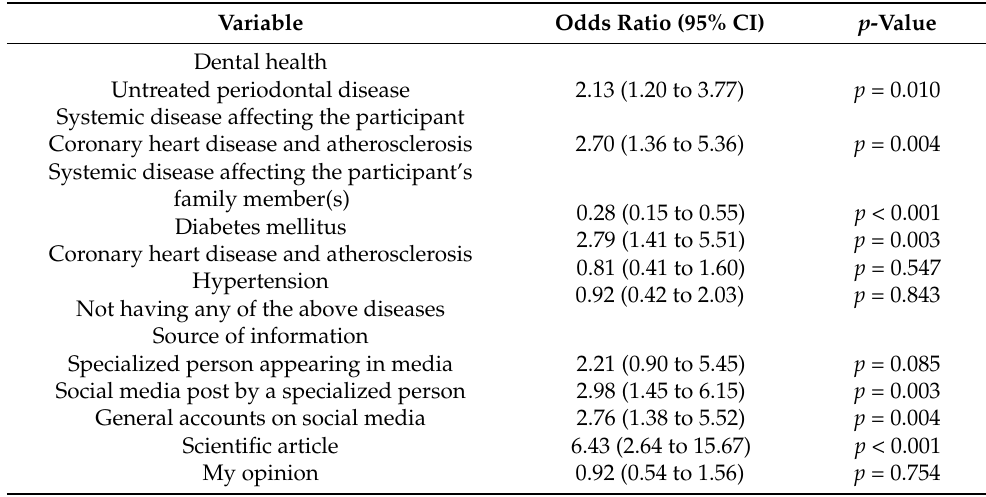
Table 10. Multivariate analysis for the association between periodontal disease and coronary heart disease and